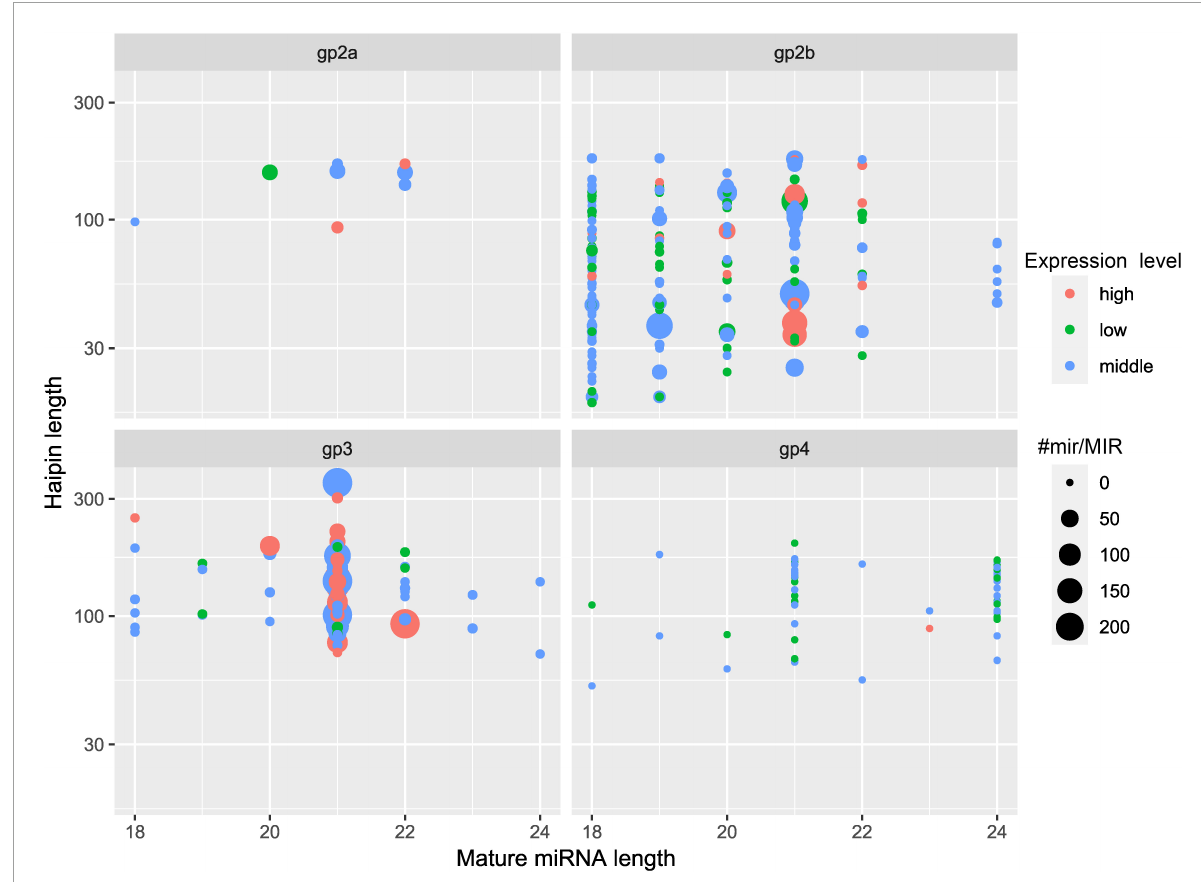
FIGURE2 Summary of the classification of the four identified groups of miRNAs in C. oleifera . Counts MIRb, the counts of miRNAs from miRBase; expression level, low indicates < 10; middle indicates > 10 but less than average; high indicates over